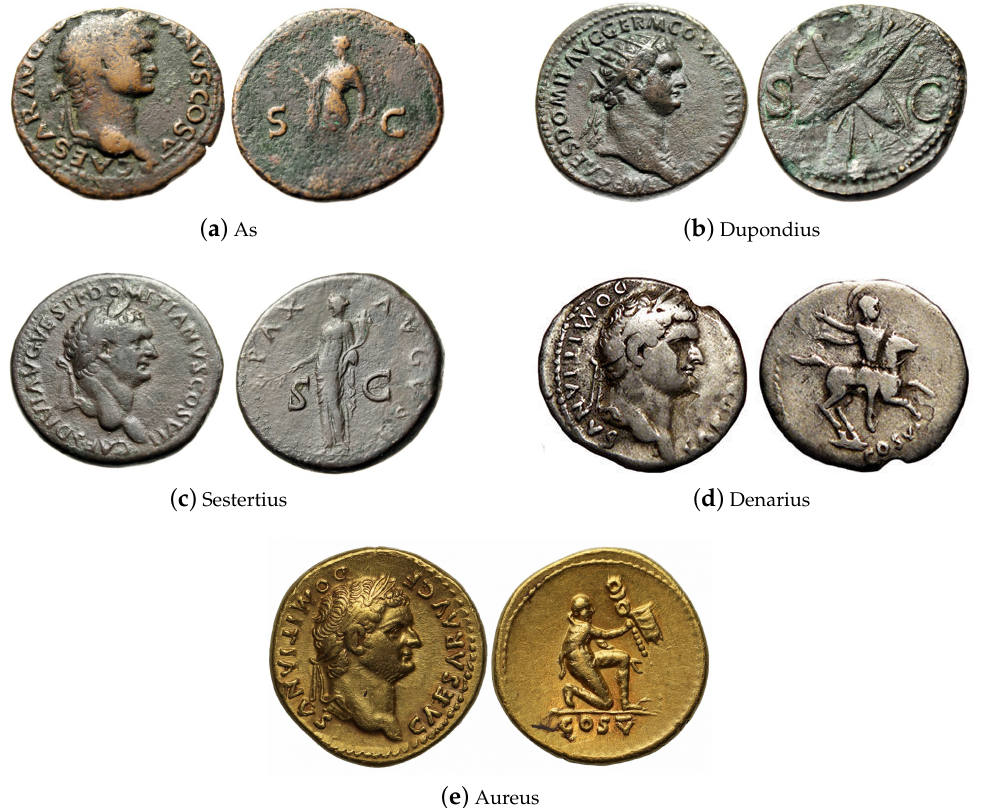
Figure 3. Coins of different denominations of the same emperor, Domitian. Shown are, in order of value at the time of their use, examples of an ( a ) as, ( b ) dupondius, ( c ) sestertius, ( d ) denarius, and ( e )